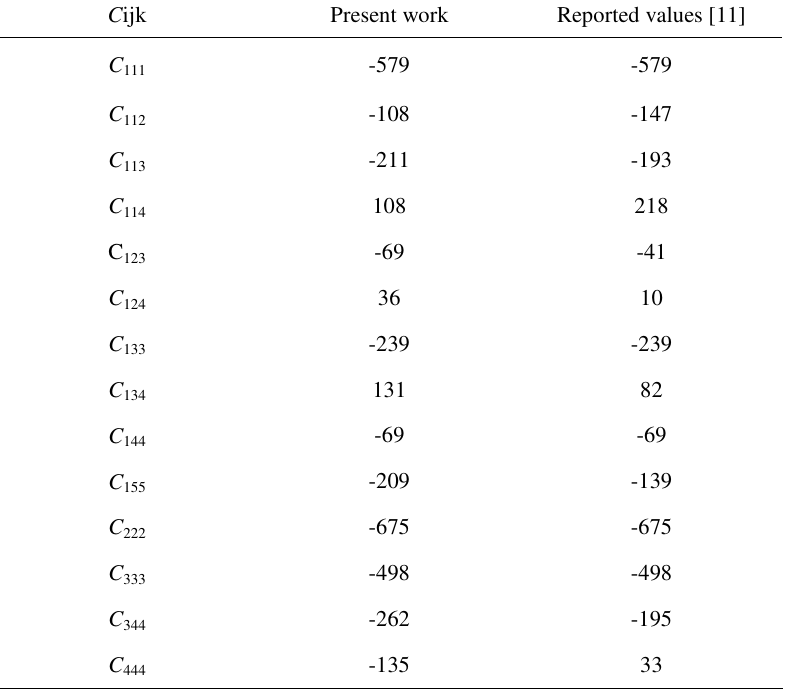
Table 5 Pressure derivatives of the second order elastic constants of